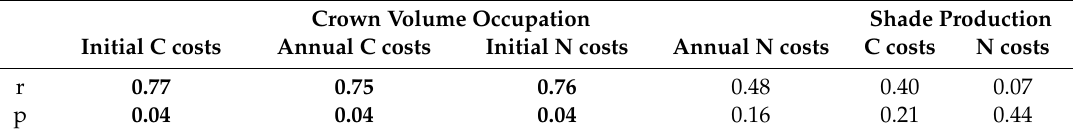
Table 3. Pearson correlation coe ffi cients ( r ) and p values of correlation analyses between ANPP and the initial and annual C or N costs of crown volume occupation and shade production in the sample of six species.